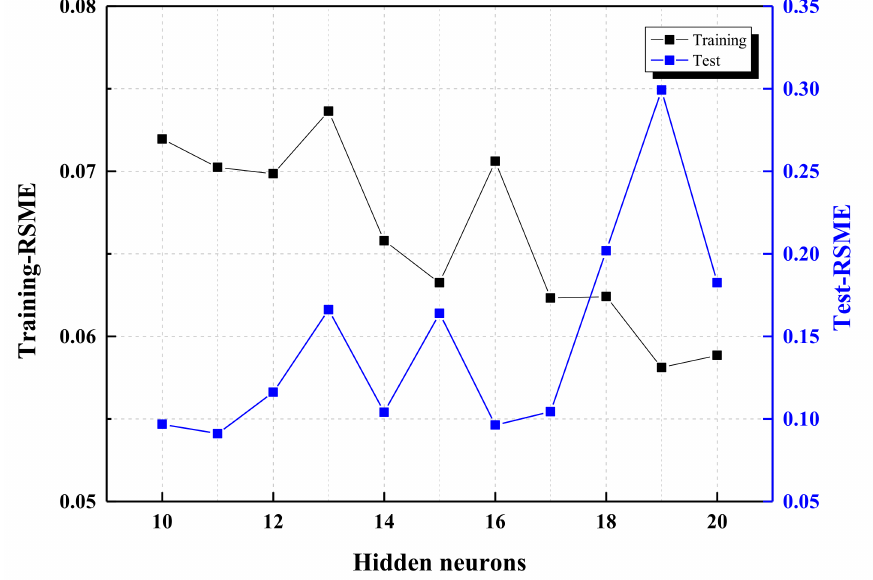
Figure 12. RSME values for different numbers of hidden layer